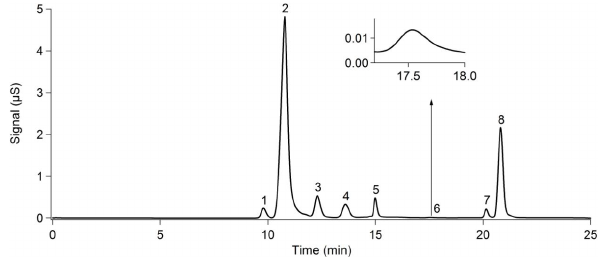
3 Figure 1. Sample CS17 chromatogram of particles collected on the 440 ± 120 nm MOUDI stage 4 Fig. 1. Sample CS17 chromatogram of particles collected on at Dorset, ON. Peaks are: 1 - sodium, 2 - ammonium, 3 - potassium, 4 - dimethylamine, 5 - 5 the 440 ± 120nm MOUDI stage at Dorset, ON. Peaks are: 1 – trimethlyamine and diethylamine, 6 - triethylamine, 7 - magnesium, 8 - calcium. 6 sodium, 2 – ammonium, 3 – potassium, 4 – dimethylamine, 5 – trimethlyamine and diethylamine, 6 – triethylamine, 7 – magne- sium, 8 – calcium.